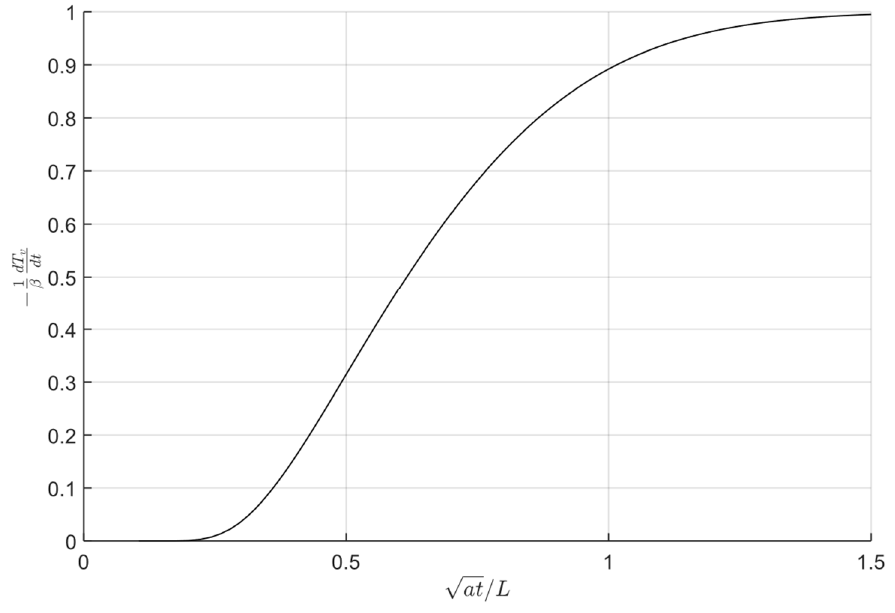
(cid:3031)(cid:3021) (cid:3297) versus the dimensionless time for the shutdown valve. Figure 4. Slope function − 1 β dT v dt versus the dimensionless time for the shutdown (cid:3031)(cid:3047) (cid:3081)